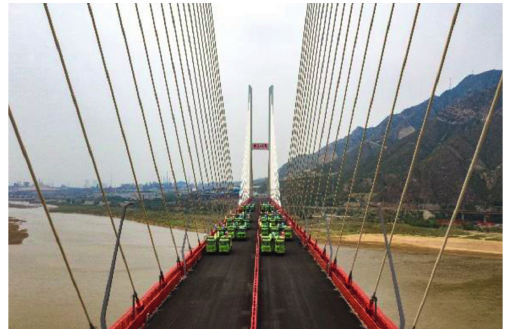
Figure 1: Yu Men Kou Huanghe River Bridge.